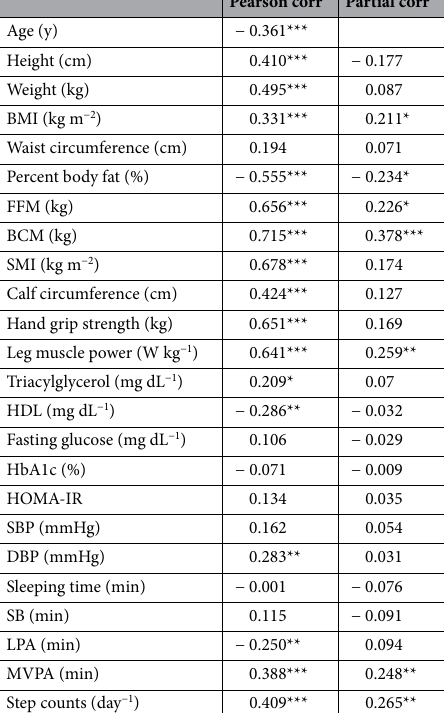
Table 2. Correlation coefficients between PhA and other variables. Age and sex were the controlling variables of partial correlation. PhA, phase angle; BMI, body mass index; FFM, fat-free mass; SMI, skeletal muscle mass index; HDL, High-density lipoprotein; SBP, systolic blood pressure; DBP, diastolic blood pressure; SB, sedentary behavior (< 1.5 METs); LPA, light intensity physical activity (1.5–2.9 METs); MVPA, moderate-to-